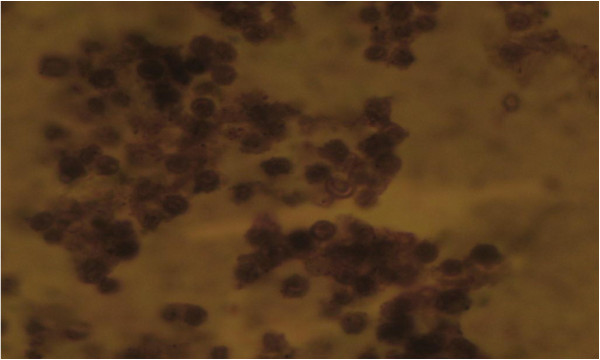
Picture of blood collected from a sickle cell blood (Magnification: x1000).